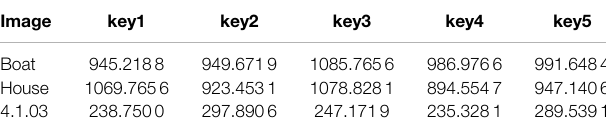
TABLE 3 | Statistical table of histogram variance after encryption with different keys